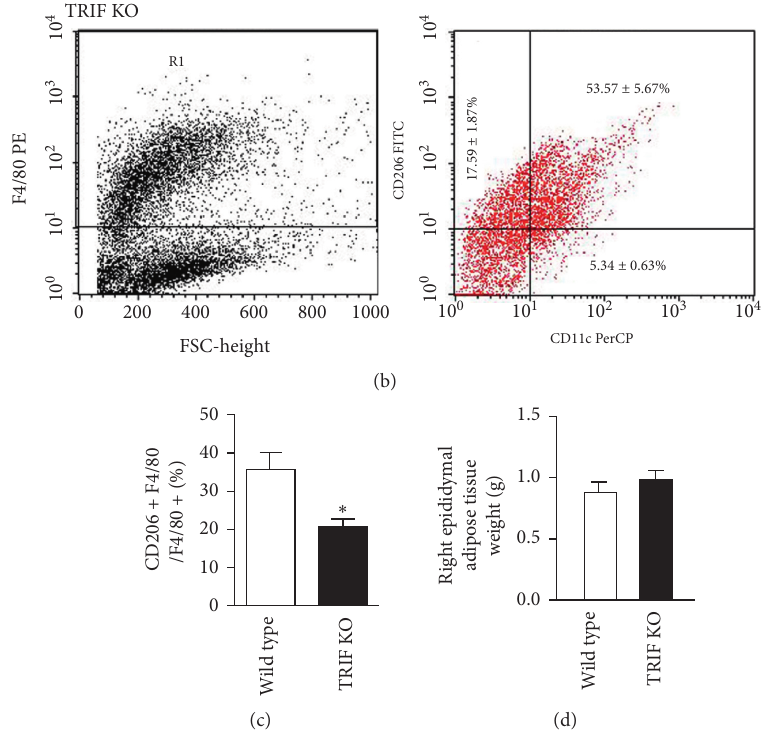
Figure 3: Effects of TRIF deficiency on macrophages in adipose tissue. (a) Flow cytometer analyses showing expression levels of CD206 + F4/ 80 + M2 and CD11c + F4/80 + M1 macrophages in epididymal adipose tissue in wild-type mice (b) and TRIF KO mice. (c) Bar graphs present percentages of CD206 + F4/80 + M2 macrophages in F4/80 + macrophages. (d) The weights of right epididymal adipose tissue ( ∗ P < 0 . 05) ( n �